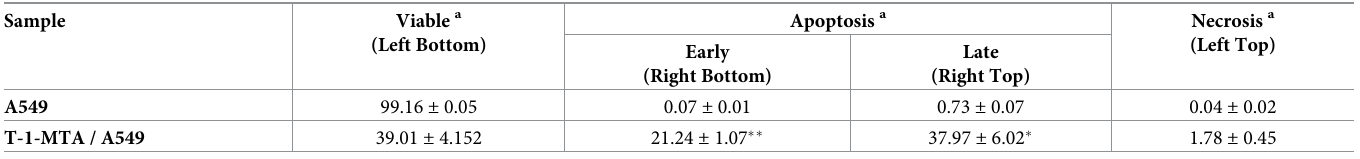
Table 7. Effect of T-1-MTA on stages of the cell death process in A549 cells after 72 h treatment.